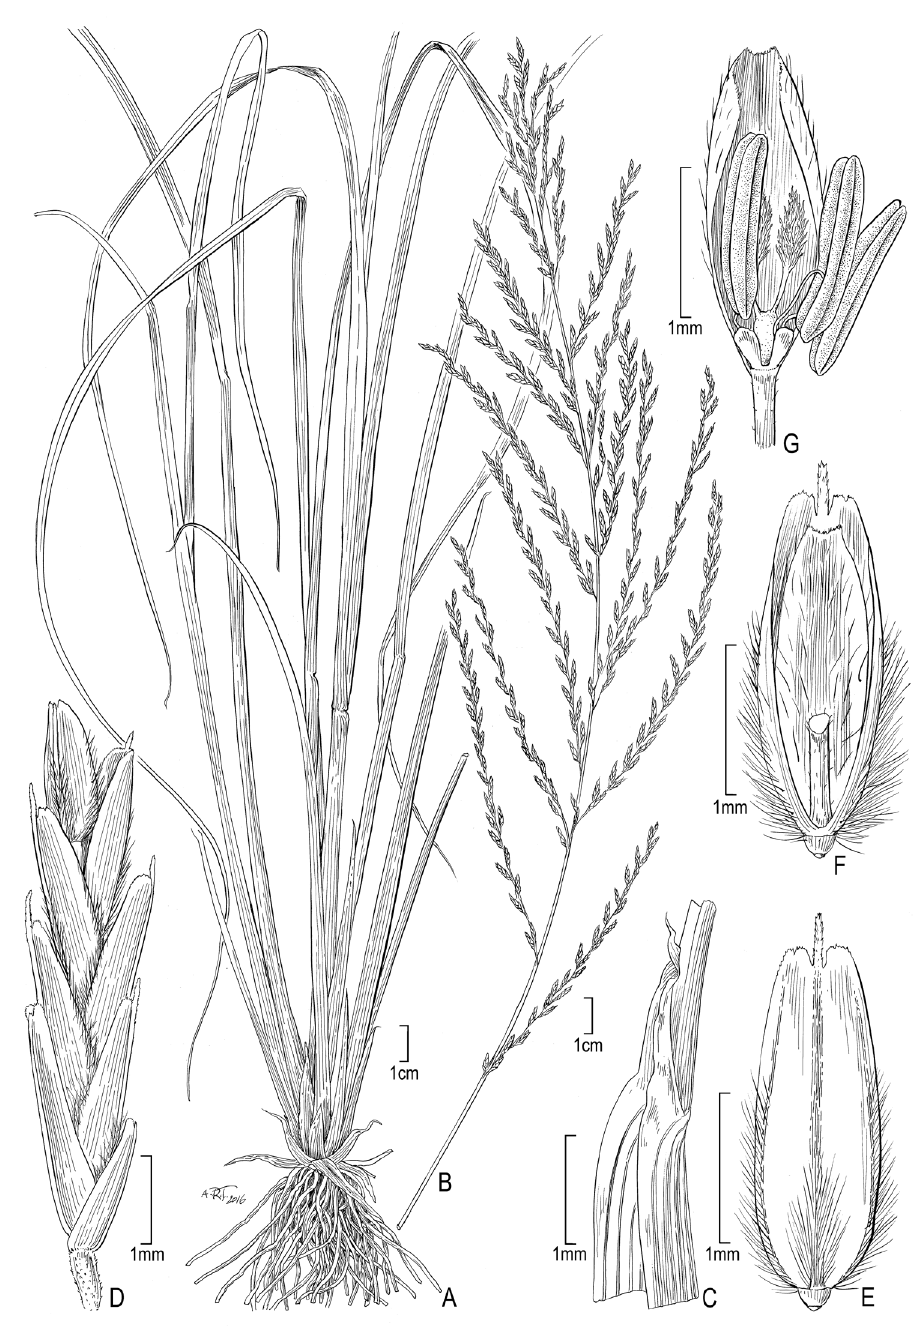
Figure 2. A–G Diplachne fusca (L.) Kunth subsp. fusca A habit B inflorescence C ligule D spikelet E lemma F floret and rachilla G palea, lodicules, ovary, and stamens. Drawings from Strohbach & Sheuy- ange BD3162